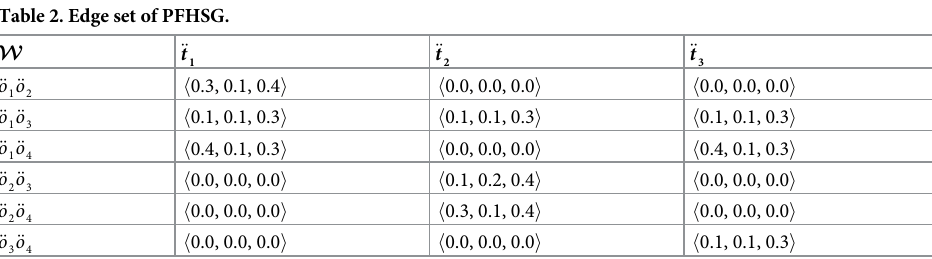
Table 2. Edge set of PFHSG.